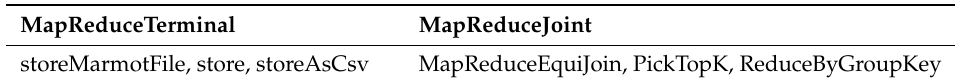
Table 2. RecordSetOperators classified as MapReduceTermial and MapReduceJoint, repectively.